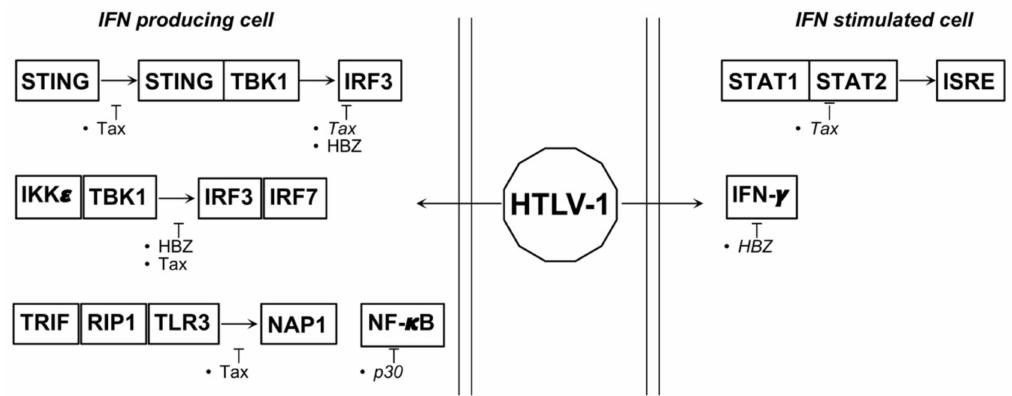
Figure 3. Proteins and miRNAs able to deregulate type I IFNs relevant pathways during HTLV-1 associated tumorigenesis. Italics represent indirect